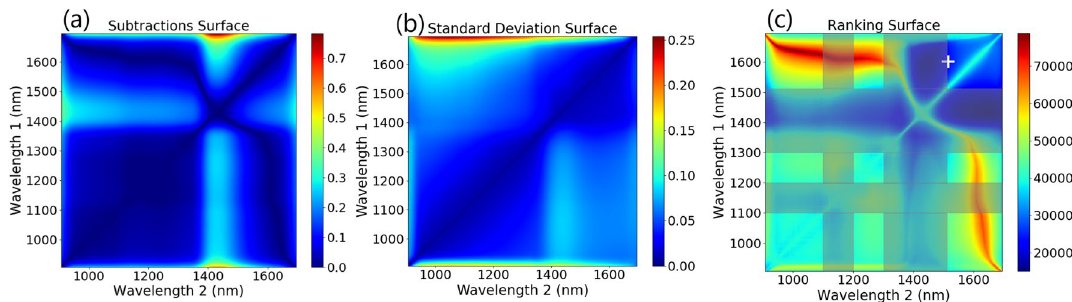
Figure 2. ( a ) Surface plot of the difference between reflectance ratios calculated for wet and dry soil (metric 1) ( b ) Standard deviation of per pixel reflectance ratio calculated for wet soil sample (metric 2) ( c ) Overall ranking surface, with darker blue colours best suited for differentiating wet and dry soil. The ratio picked for this analysis is marked with a white cross, chosen after atmospheric absorption bands were discarded (shown as greyed calculating the Euclidean distance between the mean contrast ratio of the dry soil and the mean contrast ratio of the wet soil, with the result plotted as a surface plot in Fig. 2a. For each wavelength combination covering